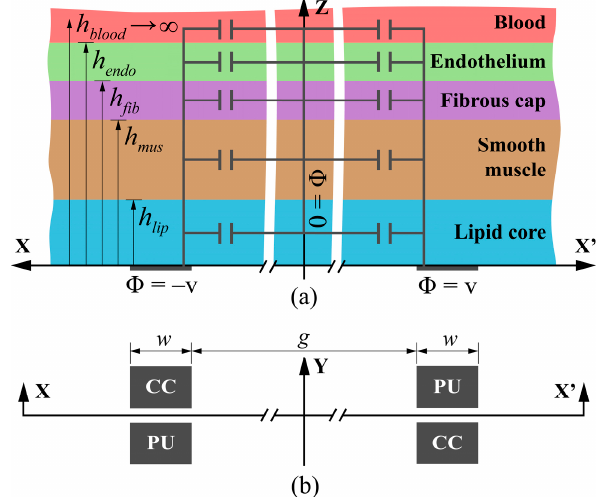
Figure 2. ( a ) Stack of neointimal tissue layers and parallel partial capacitances. ( b ) Layout of current-carrying (CC) and pick-up (PU) electrodes.